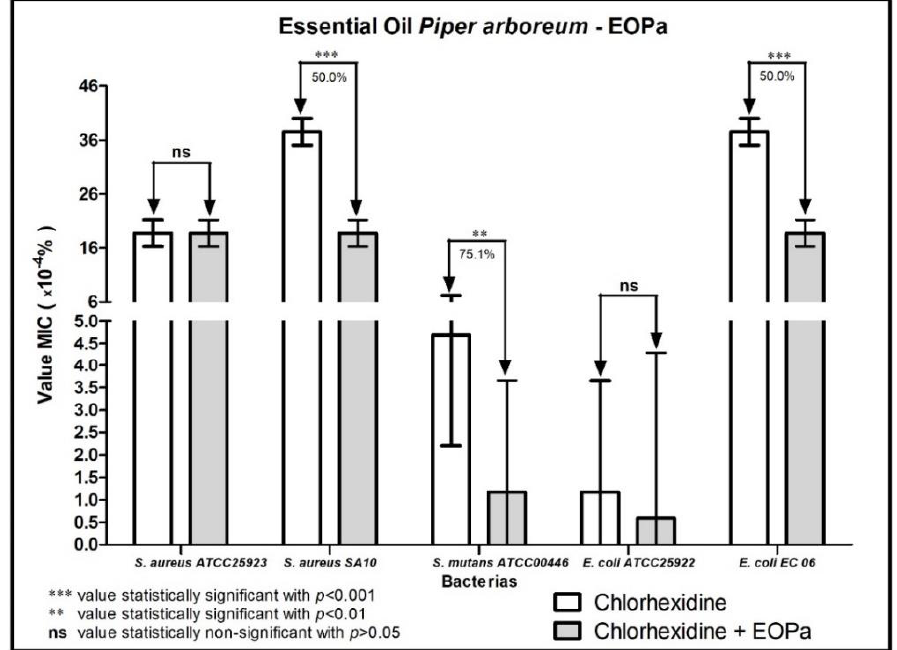
Figure 1. Evaluation of the modulatory activity of EOPa combined with chlorhexidine against bacterial strains.